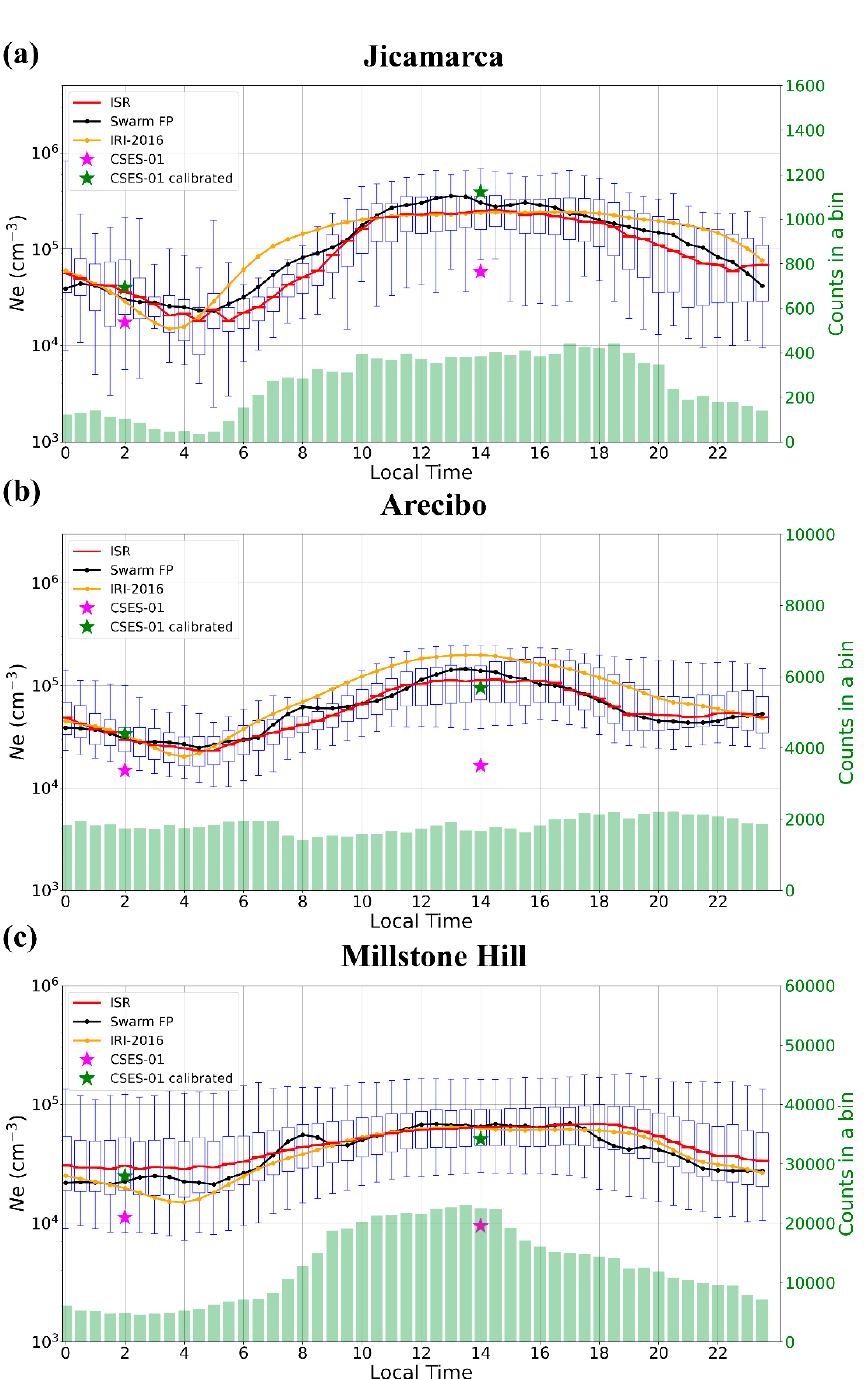
Figure 9. Statistical comparison among N e observations by ISRs at around 510 km of altitude (boxplots), Swarm B FP (black line), and CSES-01 LP (magenta star for original values, green star for calibrated values) and modelled by IRI-2016 (orange line). Panel ( a ) refers to Jicamarca, Panel ( b ) refers to Arecibo, and Panel ( c ) refers to Millstone Hill. Both measured and modelled data are binned as a function of LT ( x -axis) in bins 30 min wide. ISRs data are represented as boxplots in which the red line is the median; the 25th and 75th percentiles are represented as the lower and upper limits of each box, and the vertical lines extending from the boxes represent the 5th and 95th percentiles. Green vertical bars at the bottom of each panel represent the number of ISRs data falling in that bin. For CSES-01 LP, Swarm B FP, and IRI-2016, only the median of values falling within each LT bin is represented.